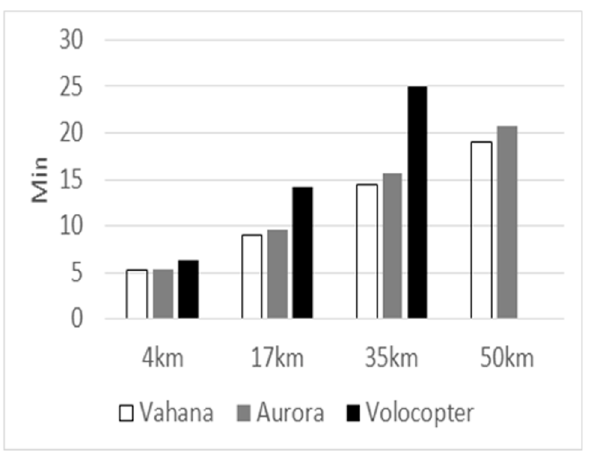
Figure 6. Mission profile and speed.